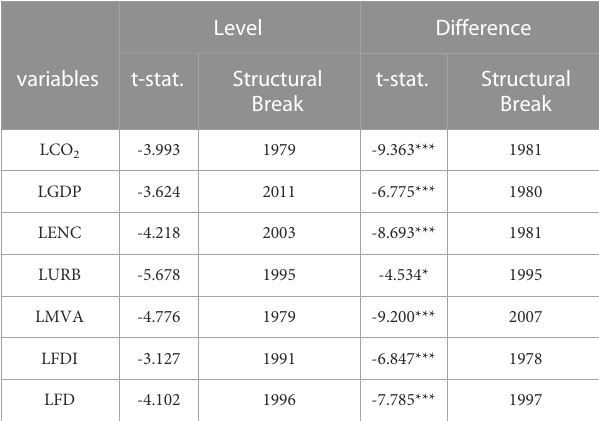
TABLE 4 Perron structural break